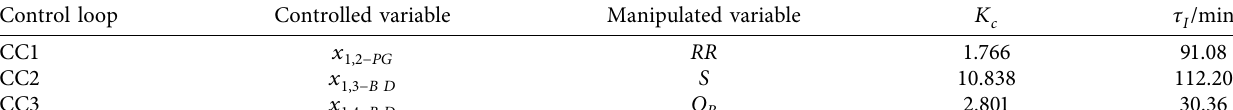
Table 3: Controller tuning parameters of CS2.